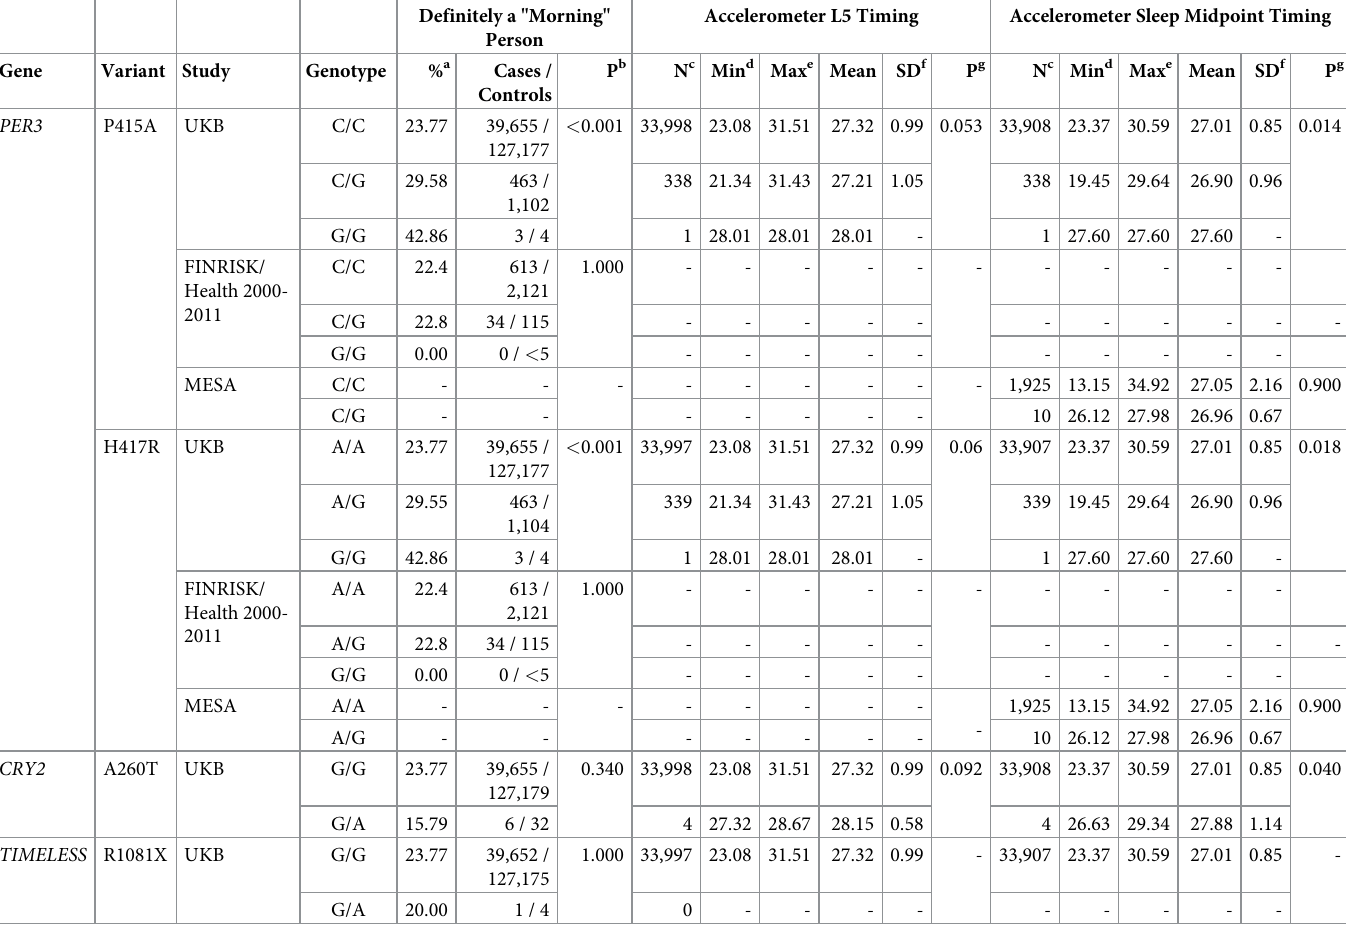
Table 4. Proportion of individuals self-reporting as being “definitely a morning person”, average L5 timing, and average of sleep-midpoint across all nights for each genotype group of variants previously reported to be causal for familial advanced sleep phase in the UK Biobank (UKB), Finnish and MESA studies. Acceler- ometer-based estimates of sleep timing unavailable in the Finnish studies. Self-reported “morningness” and accelerometer estimates of L5-timing unavailable in